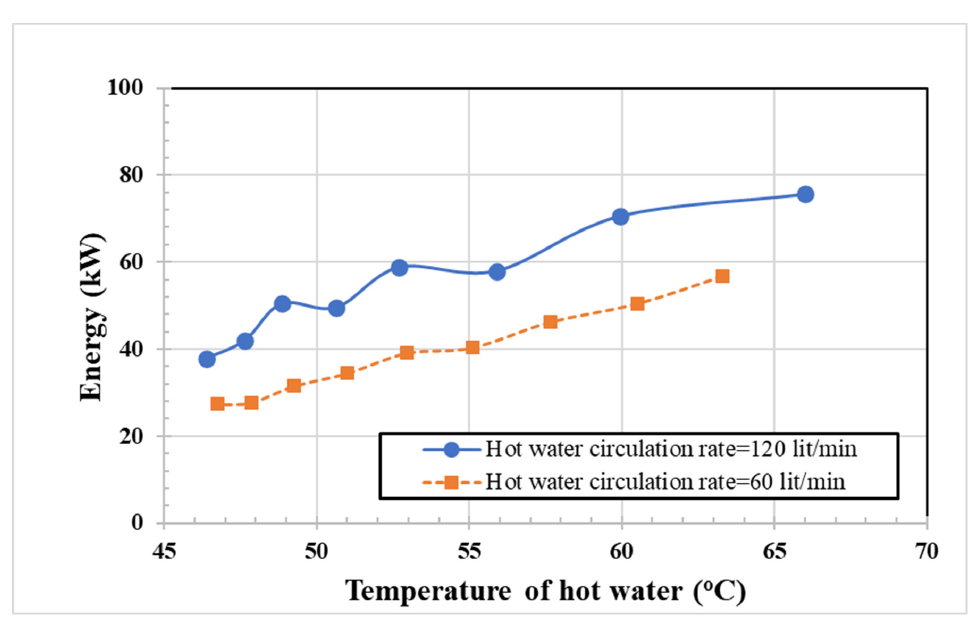
Figure 14. Energy consumption of system versus hot seawater temperature at two levels of seawater flow rate.